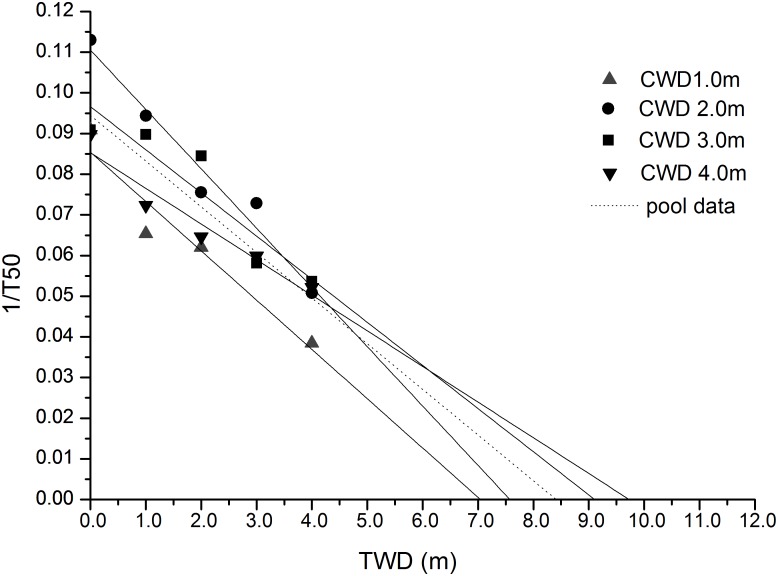
Linear regression analysis between TWD and 1/T50.